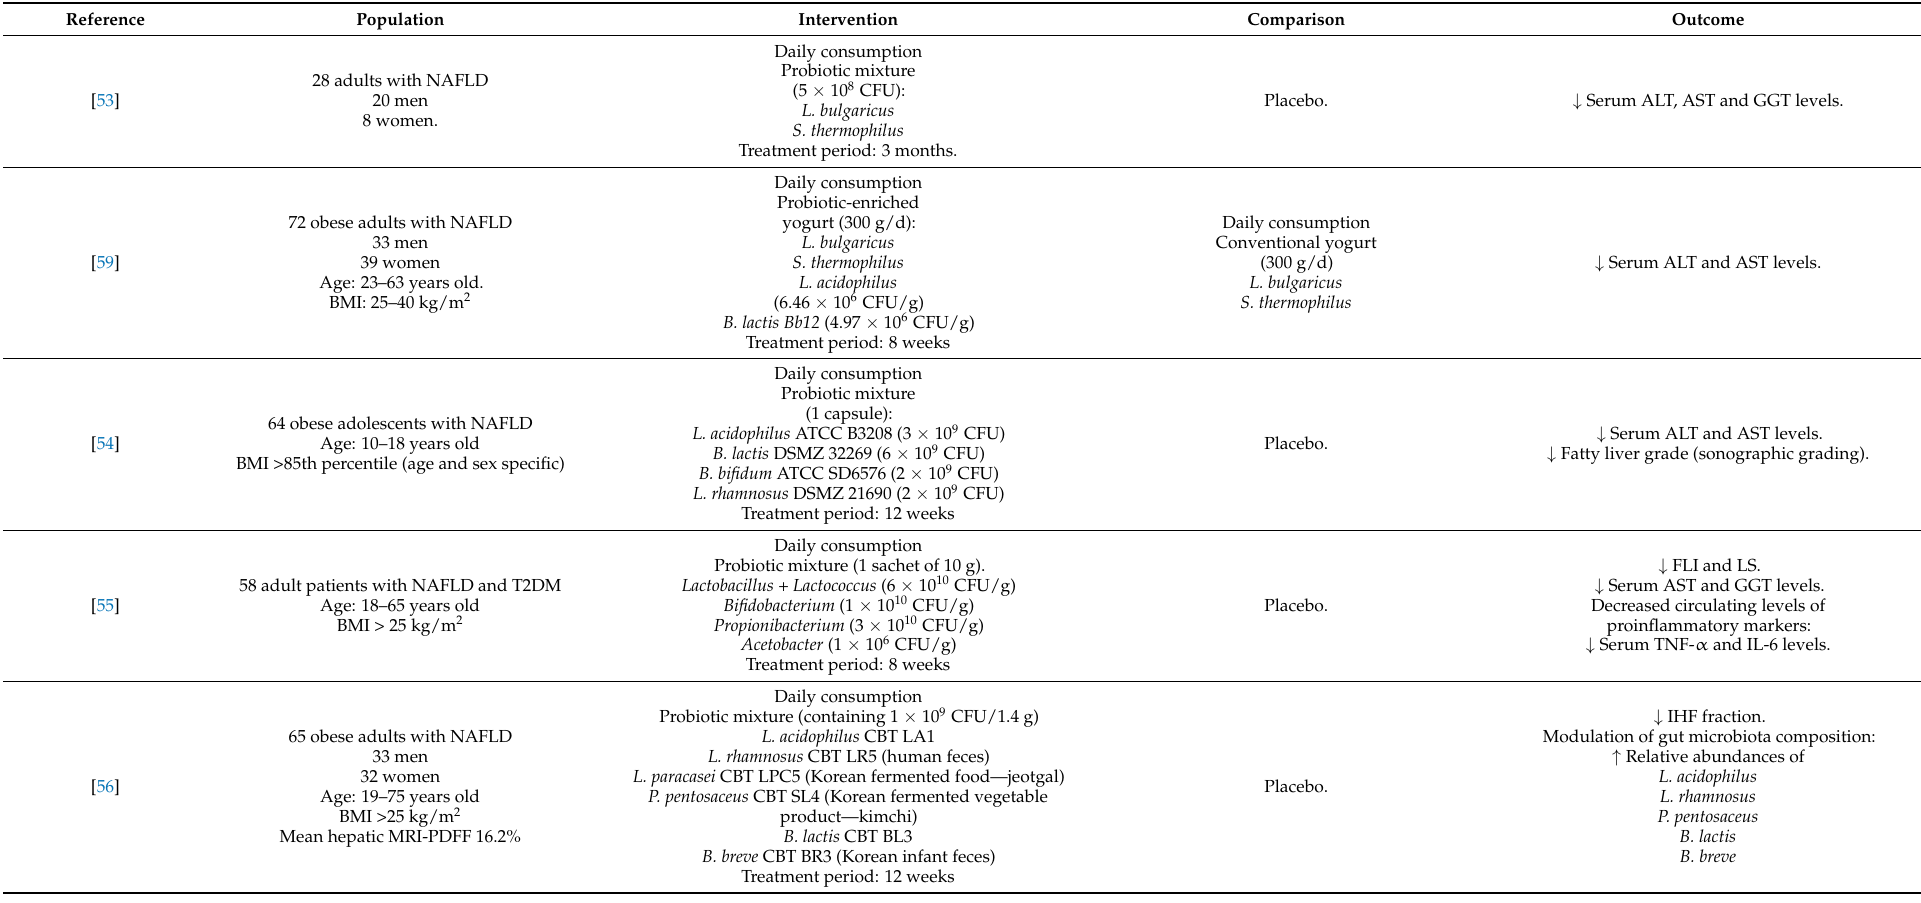
Table 3. Studies conducted in humans addressing the effects of different probiotics (single strain and mixtures) in NAFLD treatment (PICO format). Reference Population Intervention Comparison